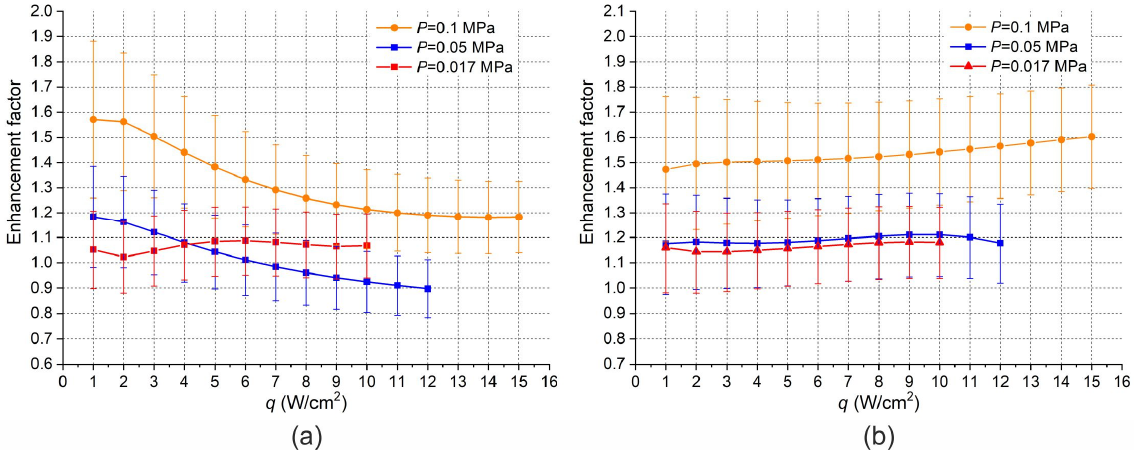
Figure 5. Intensification of heat transfer at different pressures: ( a ) sample No. 1; ( b ) sample No. 2.